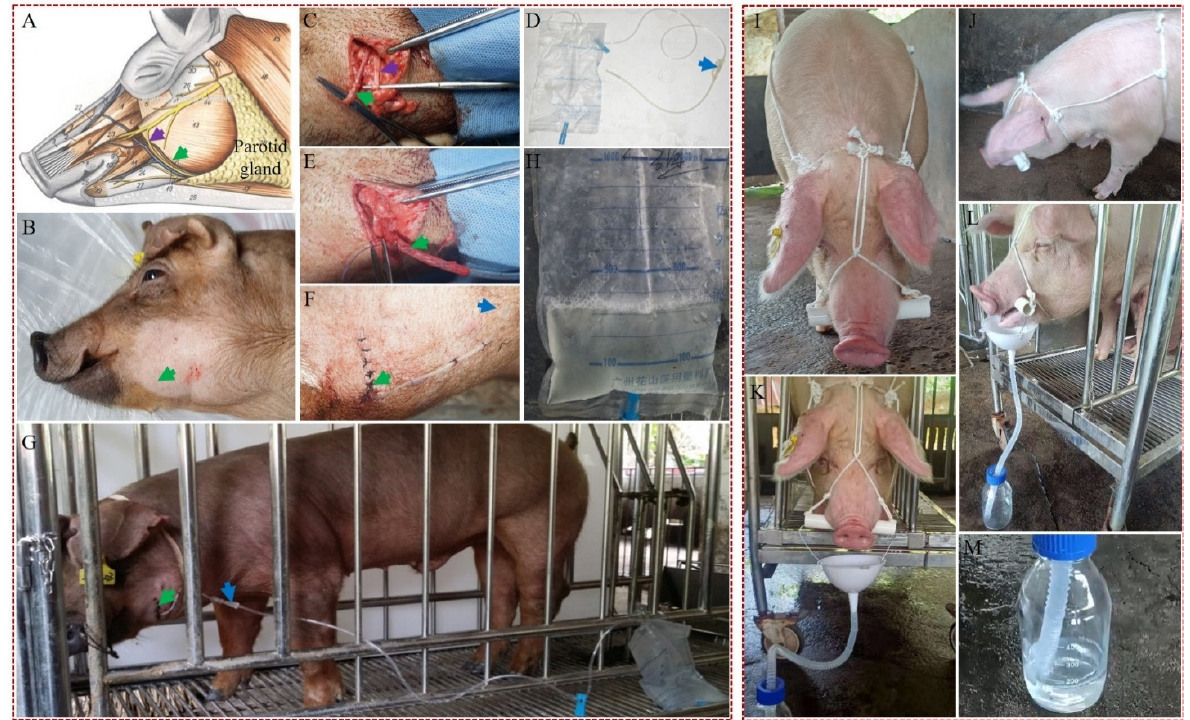
Figure 2. Development of a unilateral parotid duct cannulation-based (UPDCB) surgical method (left panel) and a bridle-like device-based (BLDB) nonsurgical method (right panel) for efficient collection of saliva from hNGF-TG pigs. ( A ) An anatomical drawing of the pig face showing the position of parotid gland and its duct extending to the oral cavity. ( B ) A pig that is ready (under anesthesia and with its facial hair shaved) for unilateral parotid duct cannulation surgery. ( C ) Exposure of the parotid duct after facial surgery. ( D ) A medical urethral catheter and a medical drainage bag used for the parotid duct cannulation. ( E ) Cannulation of the parotid duct with a urethral catheter. ( F ) Suture of the facial wound after the parotid duct cannulation surgery. ( G ) Collection of parotid saliva from a pig by the UPDCB method. ( H ) The TG pigs’ parotid saliva collected into a drainage bag by the UPDCB method. Green, purple, and blue arrows point to the position of parotid duct, facial nerve, and urethral catheter connector, respectively. The front ( I ) and lateral ( J ) view of a TG pig wearing a bridle ‐ like device consisting of a headstall and a bit, which were made of a rope and a plastic pipe (about 3 cm in diameter), respectively. The bit is attached by the headstall, which keeps the bit in place in the mouth to make the mouths of TG pigs slightly open. The front ( K ) and lateral ( L ) view of a TG pig wearing a bridle ‐ like device attaching with a simple saliva collection device, which is composed of a funnel and a bottle. ( M ) The TG pigs’ oral saliva collected into a bottle by the BLDB method. Collection of TG pigs’ oral saliva by the BLDB nonsurgical method also was shown in Supplementary Video S1.